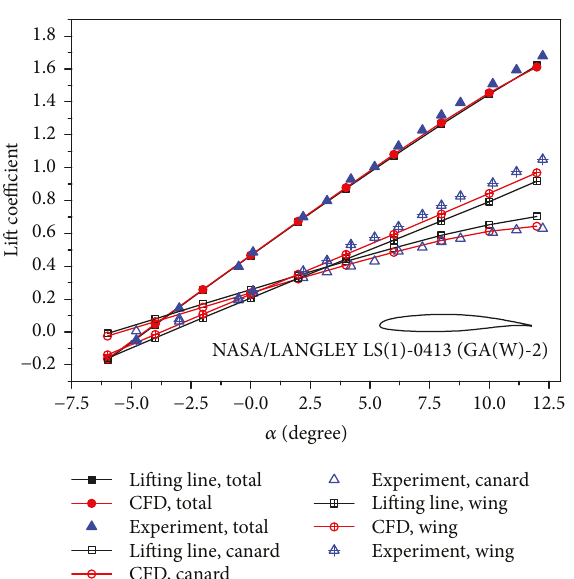
Figure 11: Lift curve comparison for tandem wing con fi guration.